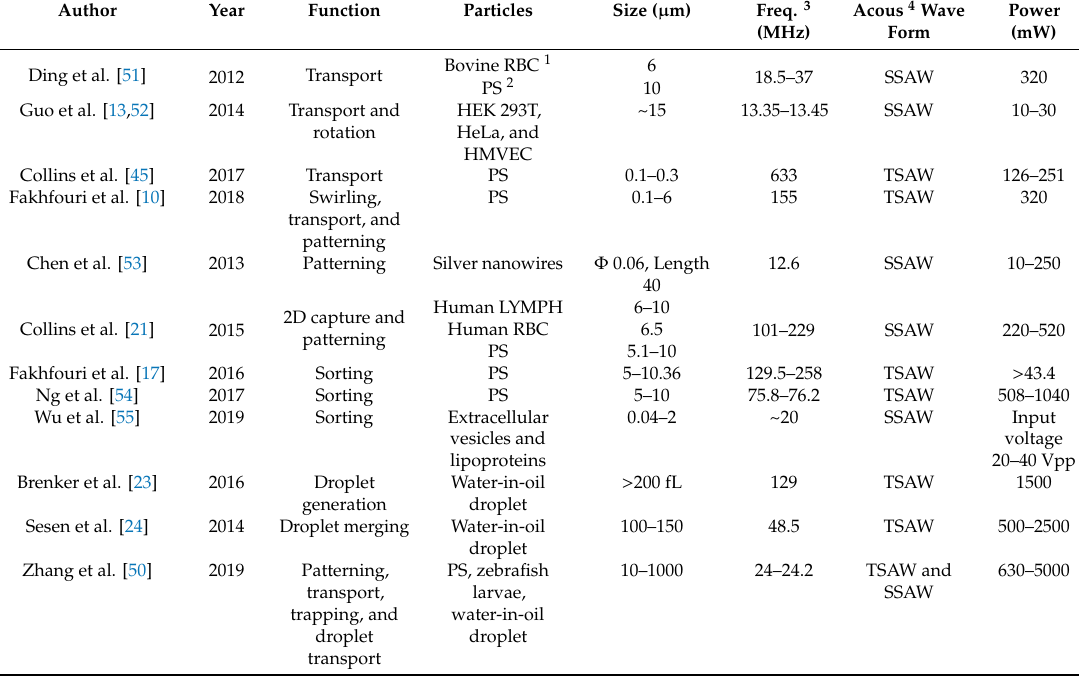
Table 1. Some in-plane manipulation research schemes in recent years. Freq,